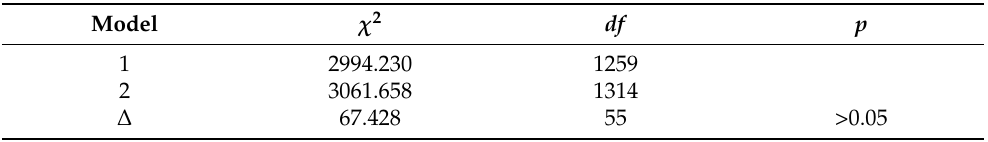
Table 1. Common method bias test.